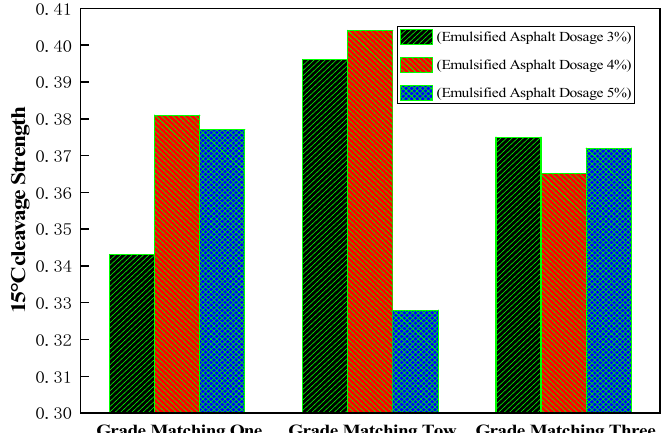
Figure 5. Strength of different asphalt mixtures with different gradations.